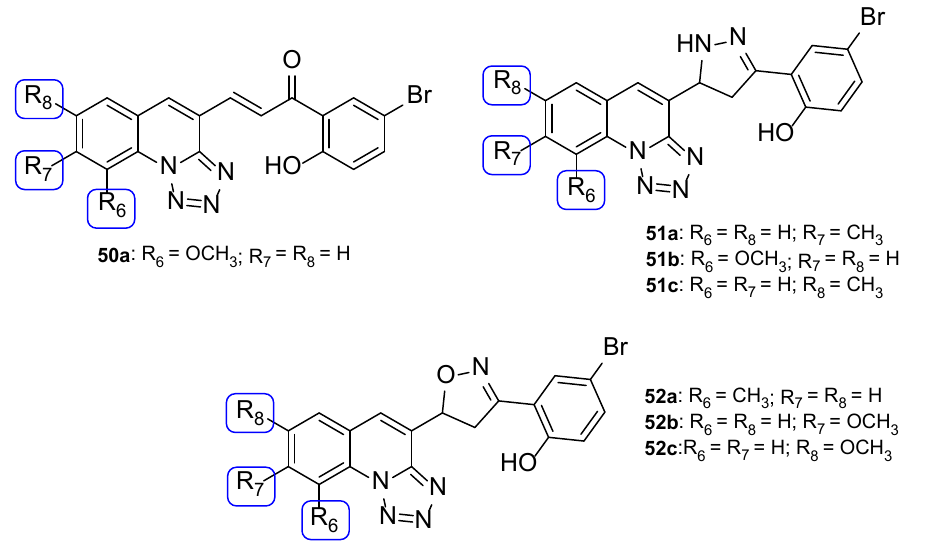
Figure 26. Chemical structures for compounds 50a , 51a – c , and 52a – c [106] .